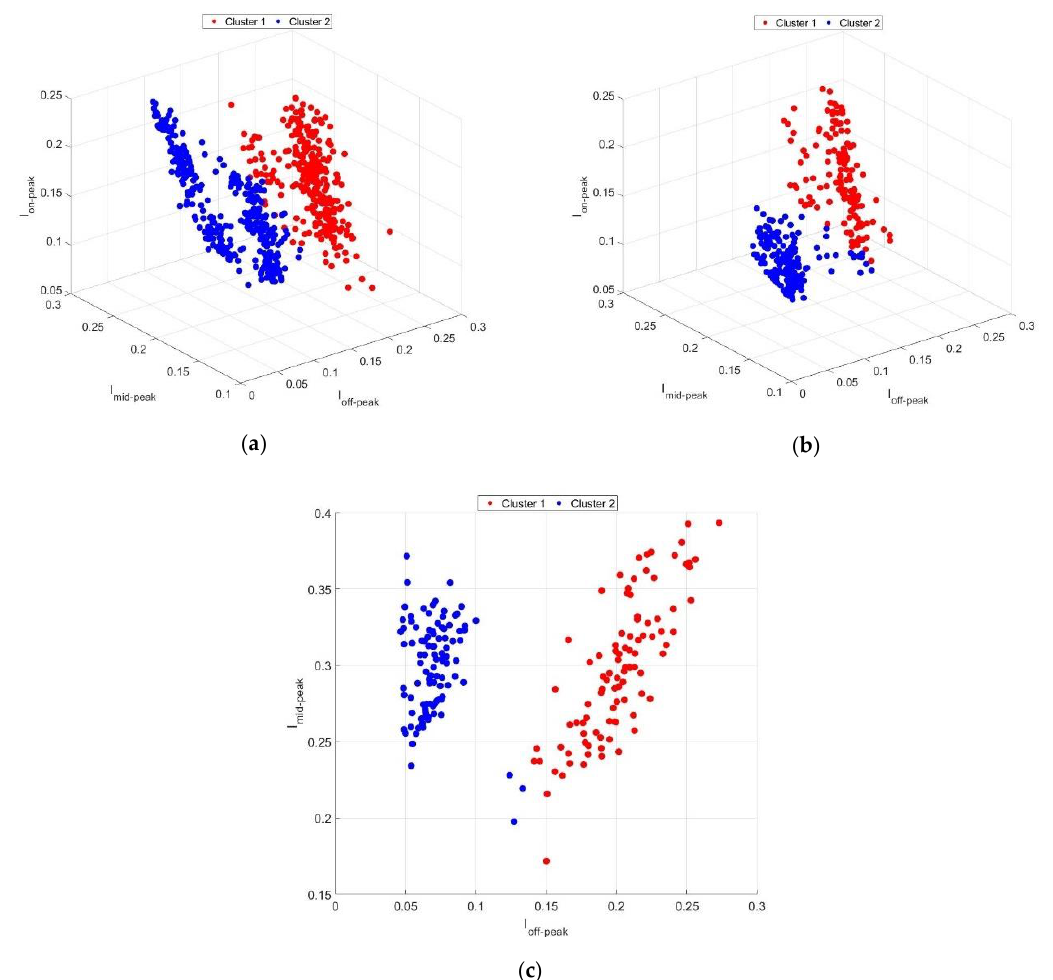
Figure 5. SOM clustering result: ( a ) Weekdays (Non-winter); ( b ) Weekdays (Winter); ( c ) Saturdays.